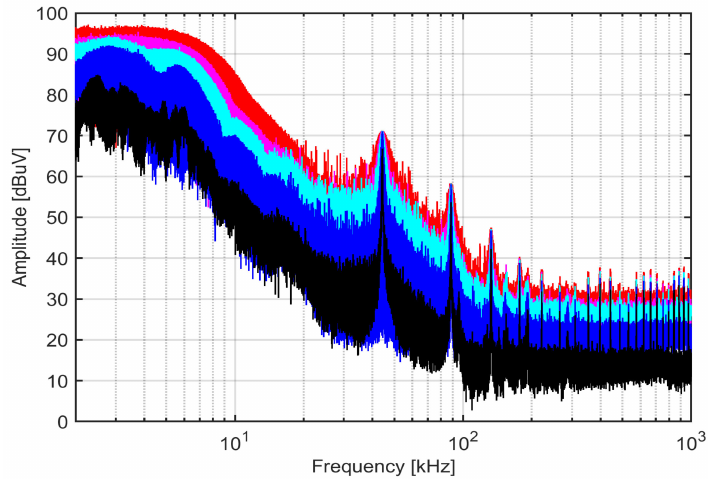
Figure 4. EMI receiver spectra with variable RBW (200 Hz, black; 1 kHz, blue; 2 kHz, light blue; 3 kHz, magenta; 5 kHz, red) for a SMPS featuring fixed switching frequency (type Black at 90% of rated